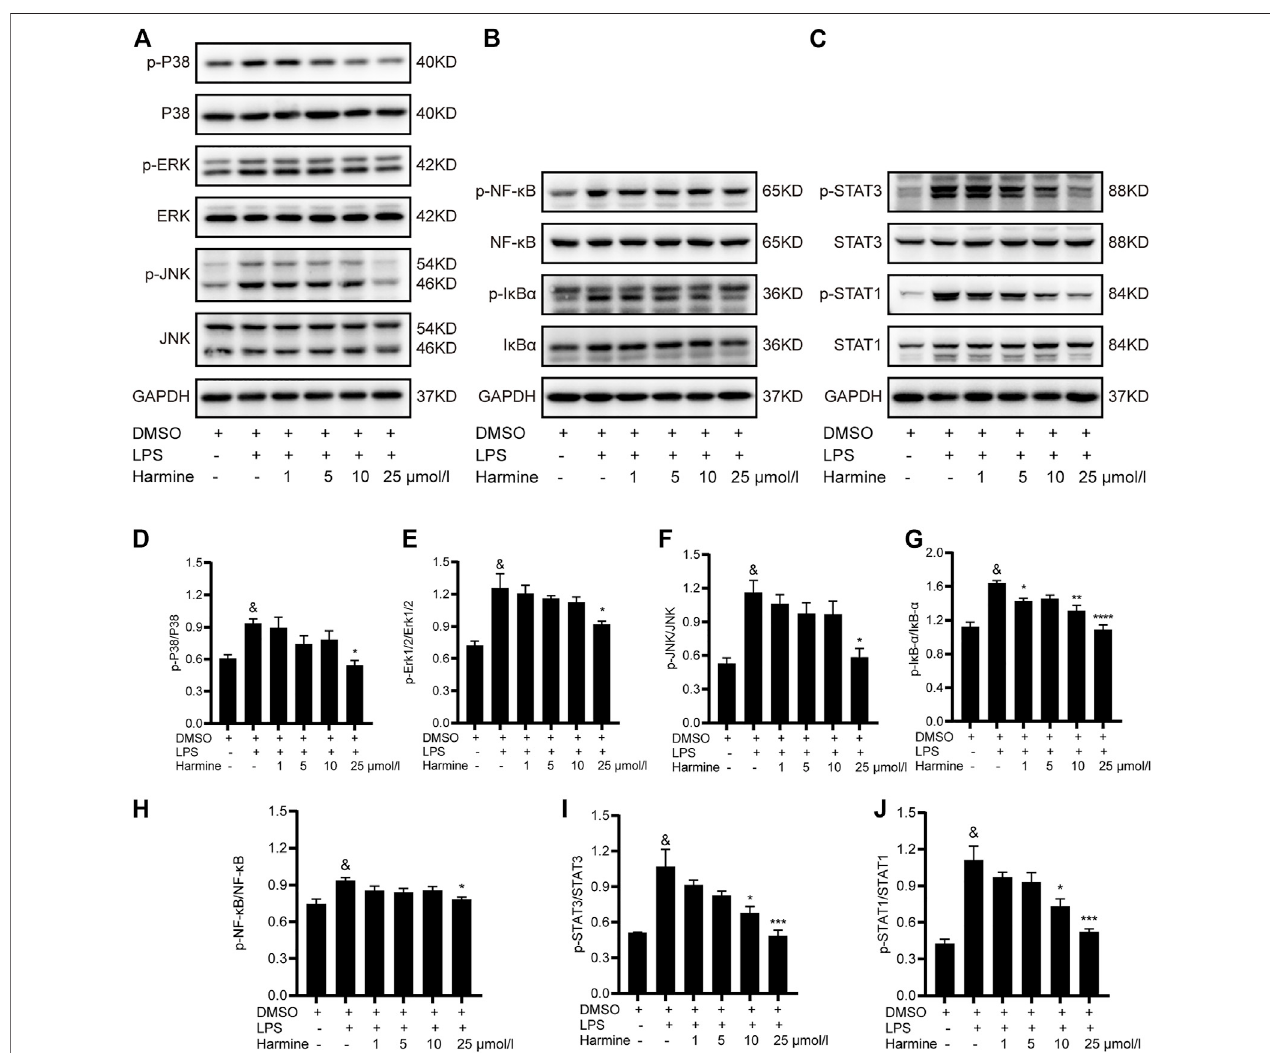
FIGURE3| Harmine inhibited M1macrophagepolarizationthroughtheSTAT1/3, MAPK, andNF- κ Bpathways. RAW264.7cellswerepretreated withharmine (1, 5, 10, or 25 μ mol/L) for 1 h and then stimulated with LPS (1 μ g/ml) for 12 h (A,D – F) Levels of proteins in MAPK pathways: p-P38 ( n (cid:1) 4), P38 ( n (cid:1) 4), JNK ( n (cid:1) 3), p-JNK ( n (cid:1) 3),Erk1/2 ( n (cid:1) 3), and p-Erk1/2 ( n (cid:1) 3), (B – H) Levelsofproteins inNF- κ Bpathways:p-NF- κ B( n (cid:1) 8), NF- κ B( n (cid:1) 8), p-I κ B- α ( n (cid:1) 4), andI κ B- α ( n (cid:1) 4), (C – J) Levelsof STAT1/3 proteins: p-STAT3 ( n (cid:1) 4), STAT3 ( n (cid:1) 4), p-STAT1 ( n (cid:1) 4), and STAT1 ( n (cid:1) 4). GAPDH was used as internal control. Data are presented as the means ± SEM, & p < 0.05 compared with the control group; * p < 0.05, ** p < 0.01, *** p < 0.001, and **** p < 0.0001 compared with the LPS group.